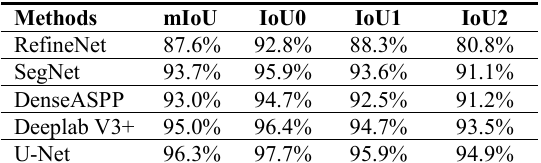
Table 1 . Performance comparison on the training dataset.